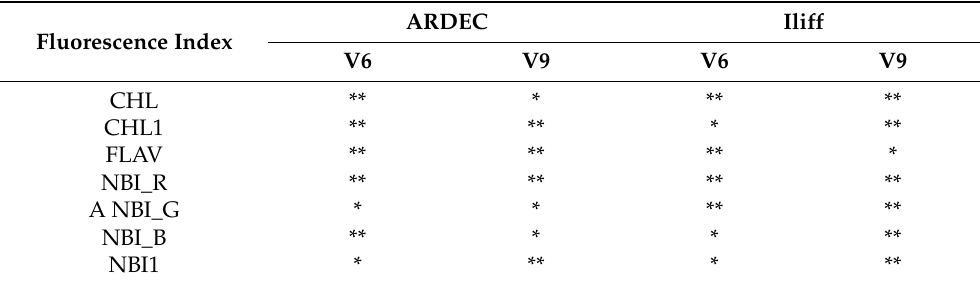
Table 2. Analysis of variance (ANOVA) of fluorescence indices at V6 and V9 growth stages of maize as affected by different N application rates at the ARDEC and Iliff sites.